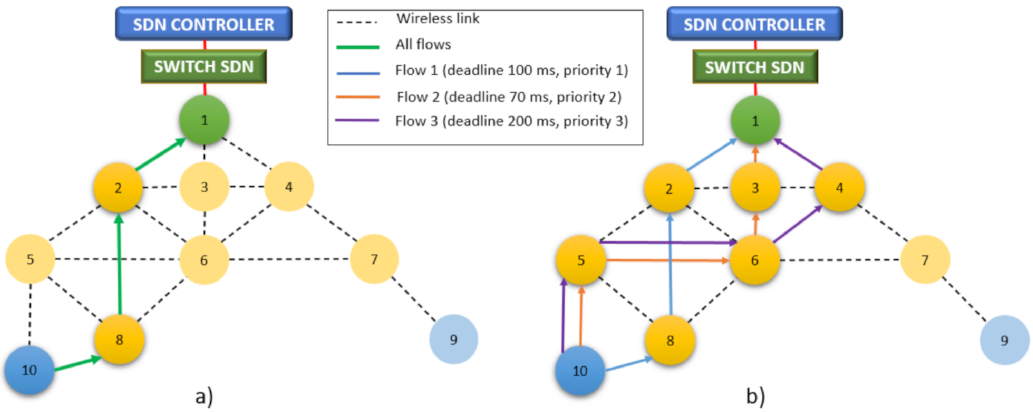
Figure 3. Flow between nodes 10 and 1. ( a ) Simple Dijkstra, based on Received Signal Strength Indicator (RSSI), ( b ) accumulated Dijkstra, balanced